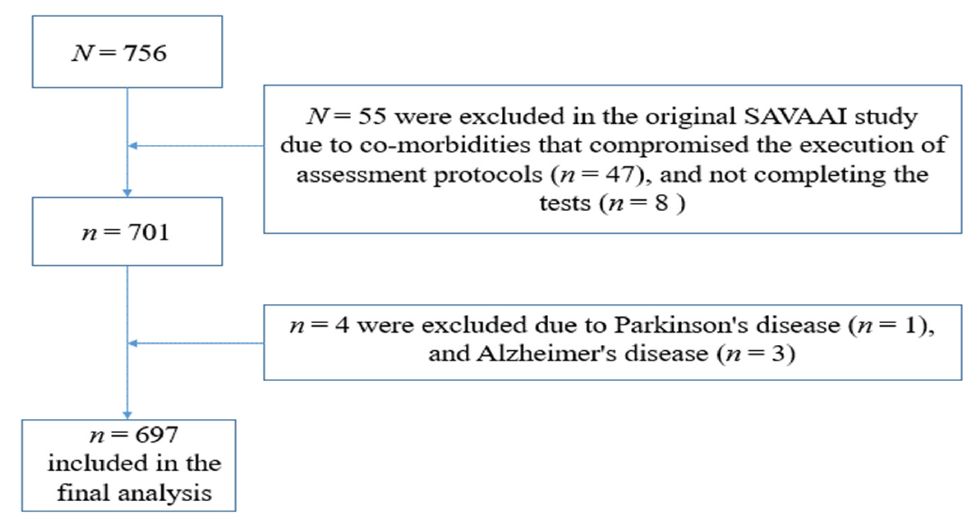
Figure 1. Flowchart of study sample.